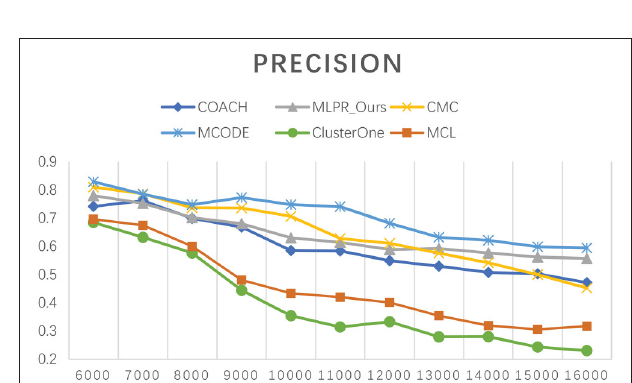
FIGURE 10 | The F -value of our method and other five methods on our reconstructed networks.